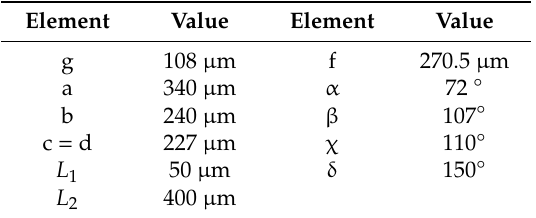
Table 7. Dimensions of the improved microgripper 2 (IMG2).